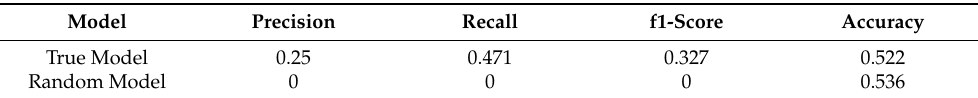
Figure 8. Evaluated results on true set and random set. ( a ) Random set results; ( b ) True set results. Table 4. Binary results of true model and random